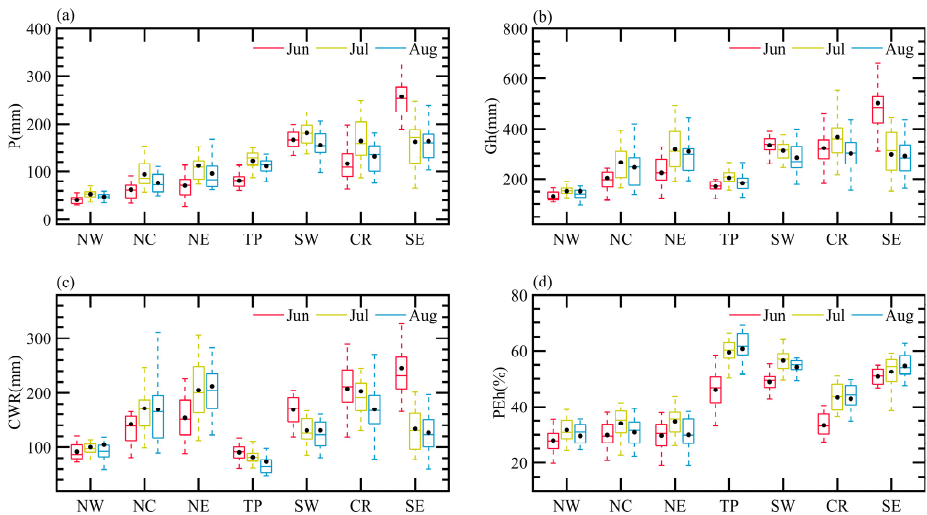
Figure 11. Box plot of summer monthly variations of ( a ) P, ( b ) Gh, ( c ) CWR, and ( d ) PEh in the seven sub-regions of China during the summers of 2001–2020. Solid lines in the boxes represent the median (Q3); the upper and lower sides of the boxes represent the upper quartile (Q4) and lower quartile (Q2), respectively; the upper and lower ends of the boxes’ lines represent 1.5 times greater than the interquartile range (IQR = Q4–Q2) of the Q4 and 1.5 times less than the IQR of the Q2, representing outliers; and the black dots in the boxes represent the mean values.